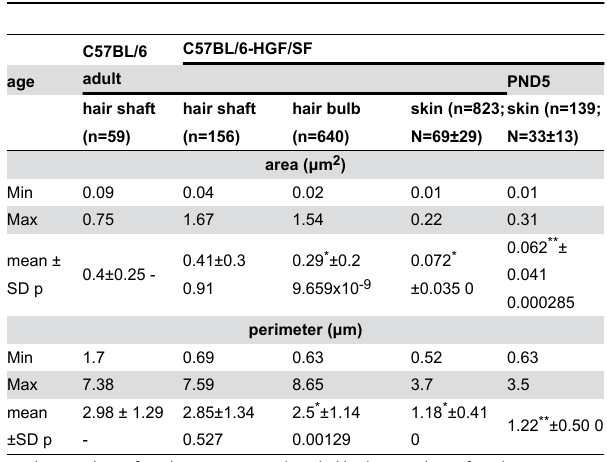
Table 1. Morphometric parameters of melanosomes in adult and pup